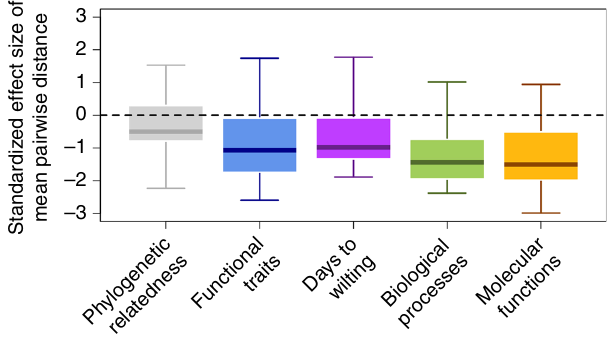
Fig. 1 Species similarity and tree co-occurrence in a Wisconsin natural forest plot. The results from null modeling analyses for 630 20 × 20 m subplots where a standardized effect size of the mean pairwise distance is on the y -axis and the type of similarity is on the x -axis. Negative standardized effect size values indicate species were more similar than expected given a random expectation and positive values indicate species were more dissimilar than expected. A linear mixed effects model ( F = 425.19; p < 0.01) with repeated measures and a Gaussian spatial covariance structure and subplot as a random effect followed by a Tukey Test showed that the boxplots were all signi fi cantly different from one another ( p <